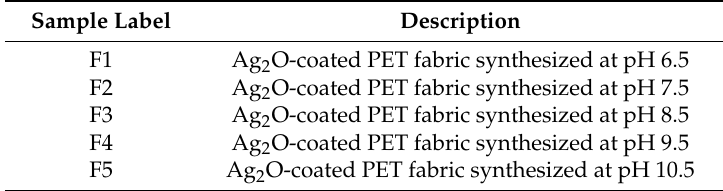
Table 1. Sample label with different pH. Legend: PET, polyethylene terephthalate. Sample